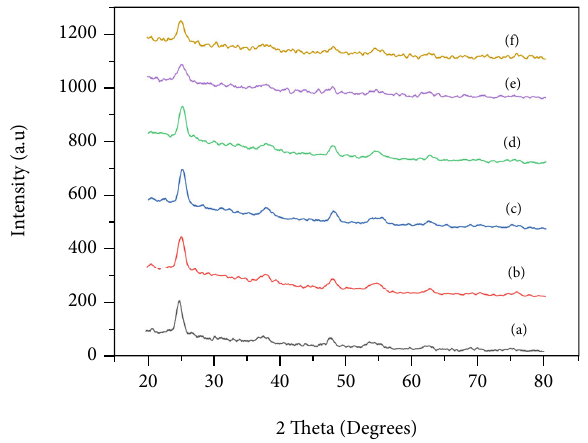
Figure 1: XRD patterns of (a) undoped TiO TiO -2.5%Co, (d) TiO 2 1%Co-2.5%Fe and (f) TiO